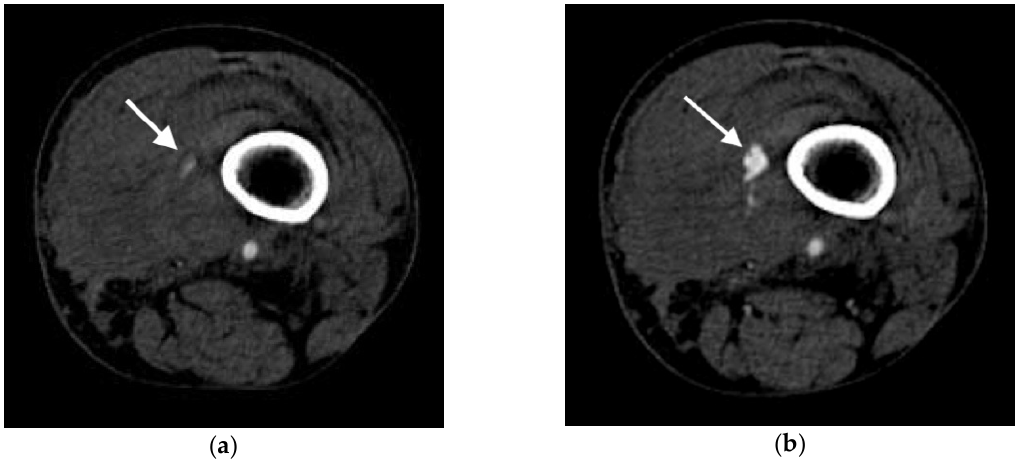
Figure 3. Axial images of active extravasation of contrast into a medial left thigh hematoma following traumatic injury to the left leg: ( a ) Small volume of contrast extravasation seen during the arterial phase (arrow); ( b ) Increase in size of the collection of extravasated contrast in the delayed phase imaging (arrow).